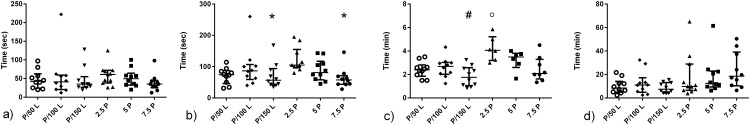
Anaesthetic parameters of adult zebrafish when treated with propofol alone or combined with lidocaine.a) equilibrium loss, b) loss of touch reaction, c) loss of reaction to a painful stimulus, and d) equilibrium recovery of adult zebrafish after being placed in an anaesthetic bath of 2.5, 5 or 7.5 μg/ml of propofol alone (P) or 2.5 μg/ml of propofol combined with 50, 100 or 150 μg/ml of lidocaine (P/L). Each point represents an animal. n = 10. Data are expressed as median [interquartile range]. * p< 0.05 compared with 2.5 μg/ml of propofol; ° p< 0.05 compared with all groups except with 5 μg/ml of propofol; #p< 0.05 compared with 5 μg/ml of propofol.